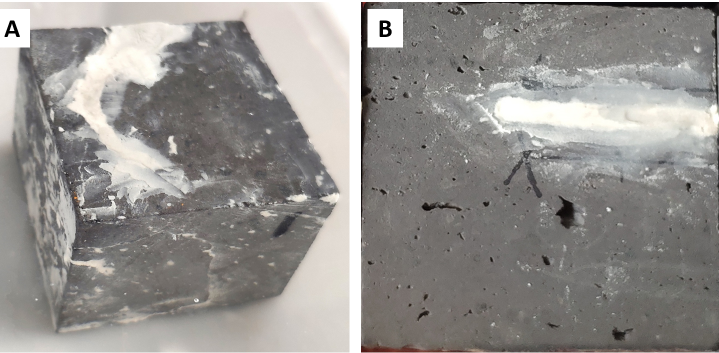
Figure 2. Close-up of the brick cubes after 7 days from MICP remediation. ( A ) Brick cubes with natural cracks; ( B ) brick cubes with simulated cracks.